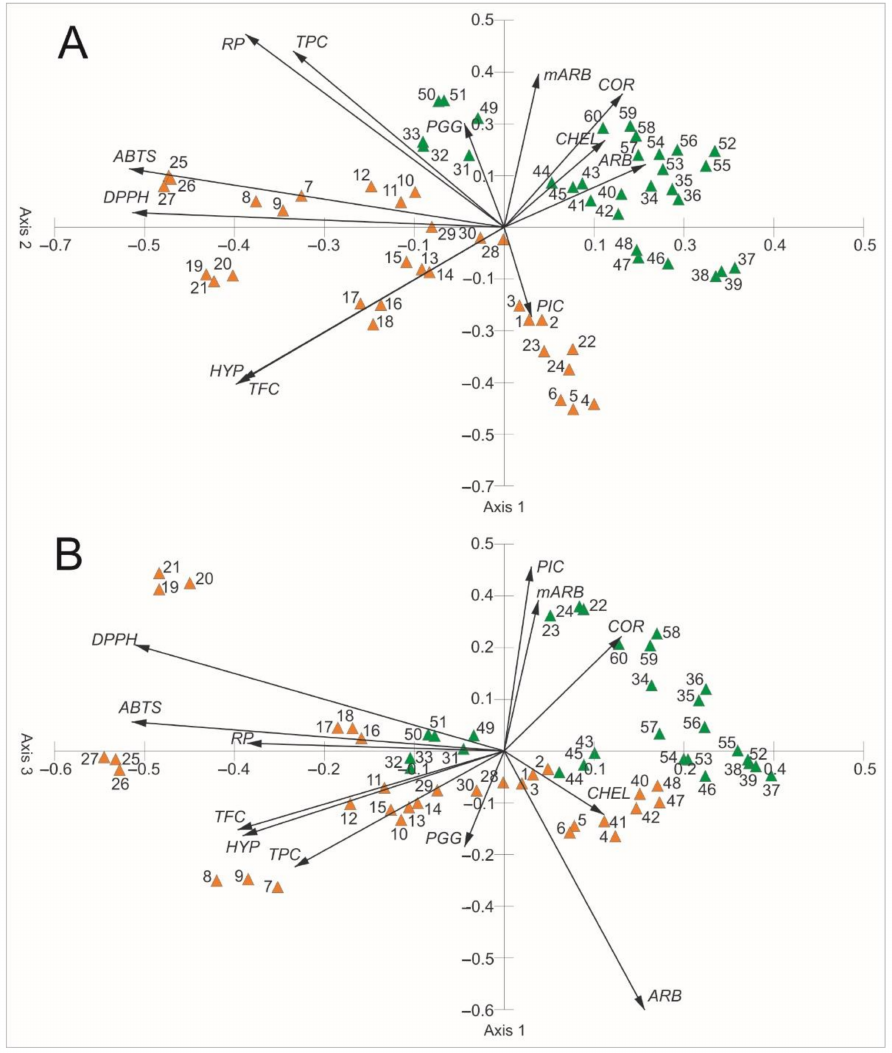
Figure 12. Results of PCA based on the chemical composition of bearberry leaf extracts and an- tioxidant activity parameters. A—Axis 1 and Axis 2, B—Axis 1 and Axis 3, ARB—arbutin,